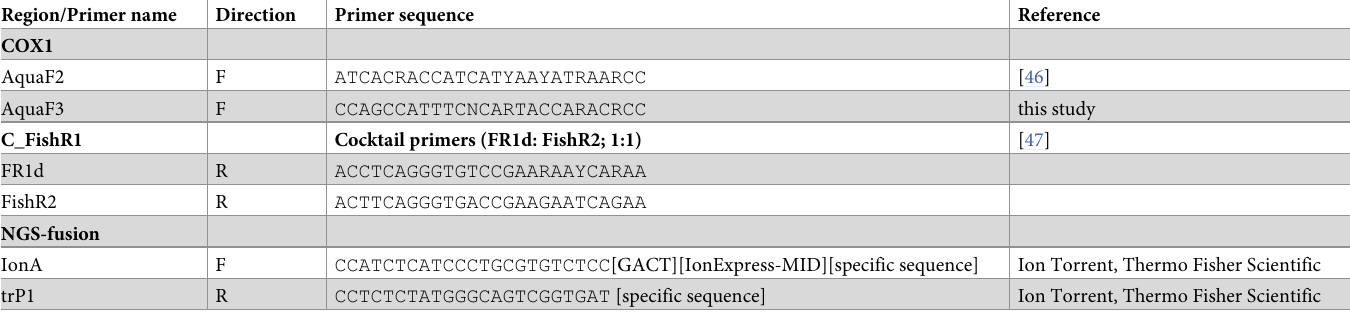
Table 1. Primers used for eDNA